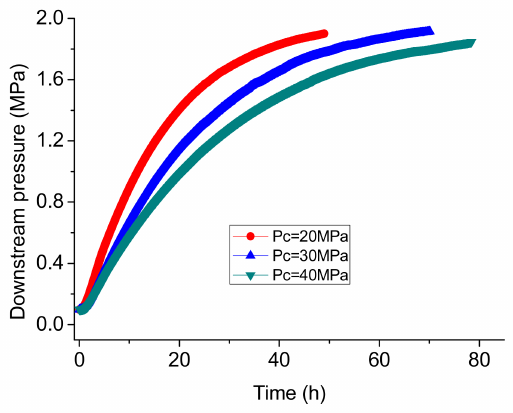
Figure 6. Development of downstream pressure with time under transient conditions at injection pressure of 2